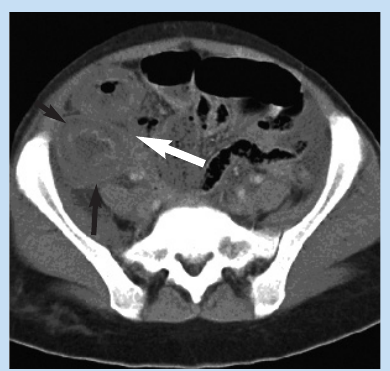
Fig. 6. Contrast enhanced CT scan at the pelvic inlet demonstrating marked caecal wall thickening (black arrows) and inflammatory reaction at the ileocaecal valve (white arrow).